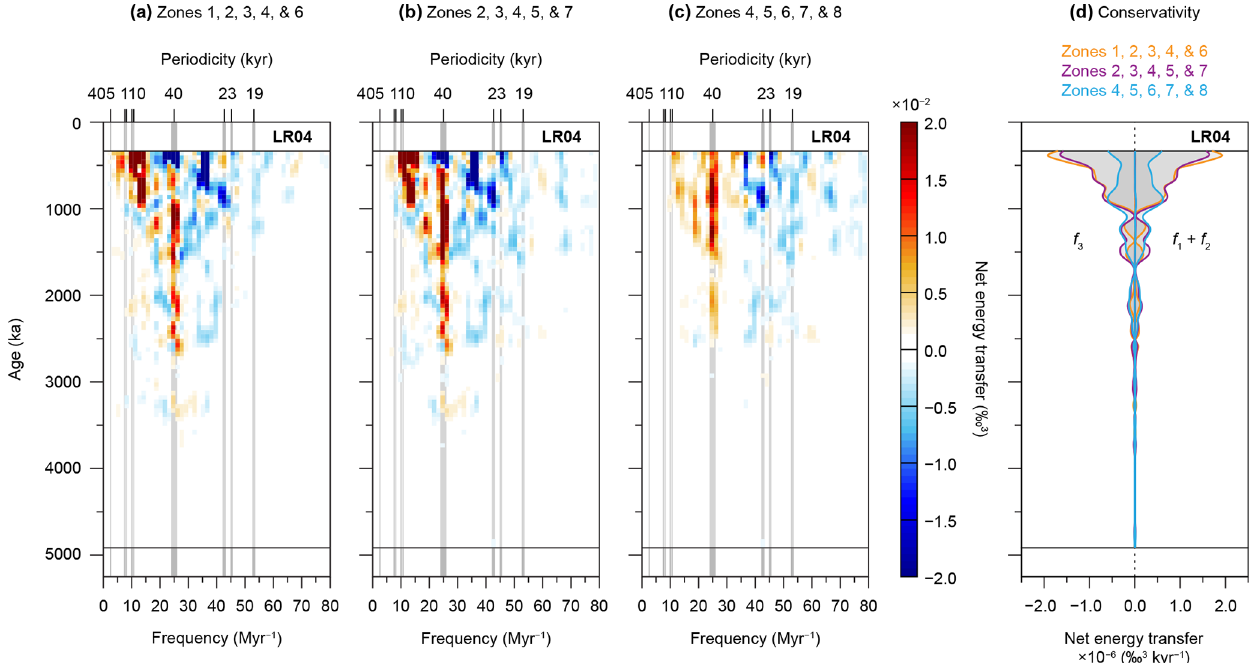
Figure 10. Summed zonal integrations of the imaginary part of Pliocene and Pleistocene bispectra. Net energy transfers are computed by (a) summing Zones 1, 2, 3, 4, and 6 for triad interactions corresponding to the “eccentricity” bandwidth, (b) summing Zones 2, 3, 4, 5, and 7 for triad interactions corresponding to the “obliquity” bandwidth, and (c) summing Zones 4, 5, 6, 7, and 8 for triad interactions corresponding to the “precession” bandwidth. Panel (d) shows the corresponding summed zonal conservation of energy, with eccentricity in orange, obliquity in purple, and precession in